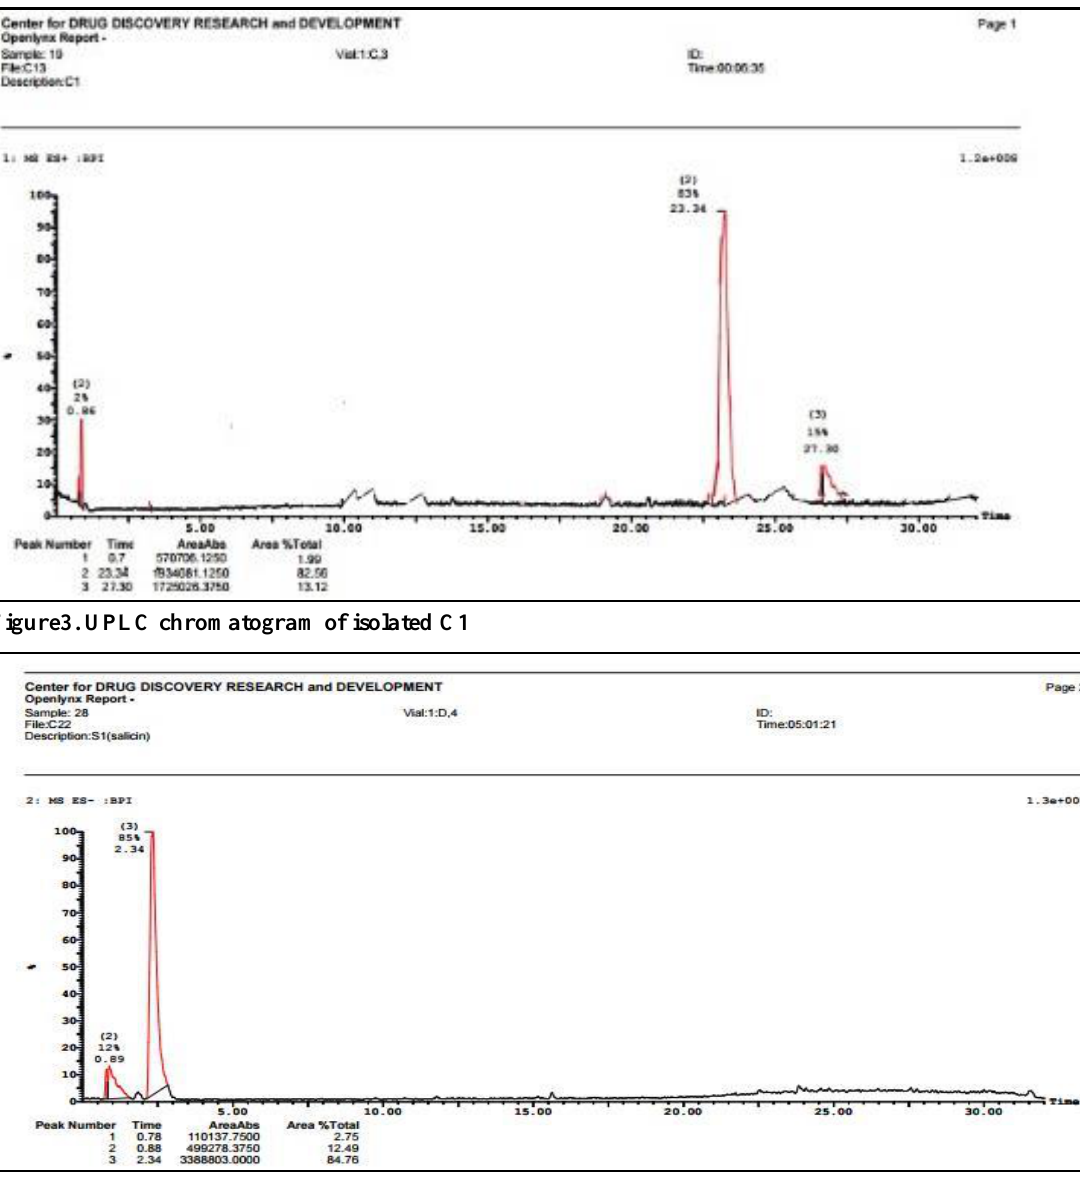
Figure 4 . UPLC chromatogram of isolated